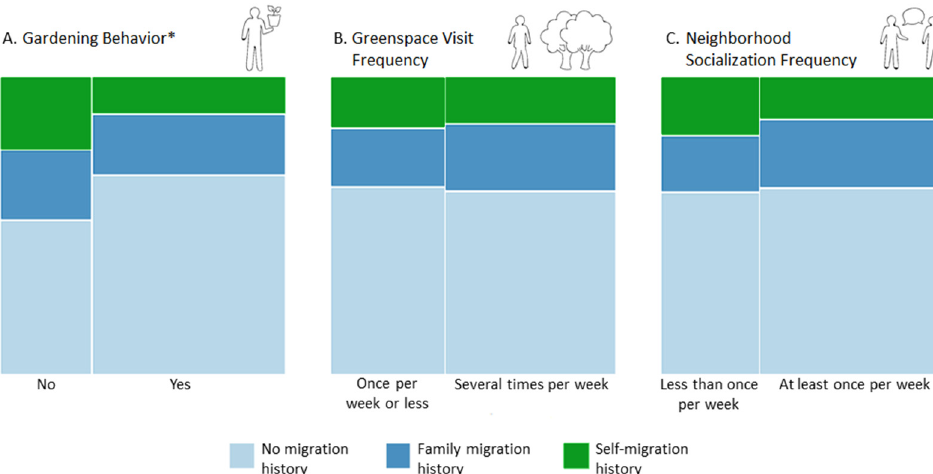
Figure 2. Mosaic plots depicting bivariate relationships between migration history and gardening behavior, greenspace visit frequency and neighborhood socialization frequency. The width of each bar represents the proportion of respondents ( n = 282) in the respective group. The height of the individual-colored sections within each bar represents the proportion of respondents in each group according to the levels within the variable migration history (i.e., no migration history, family migration history and self-migration history). The bivariate relationships depicted in the plots are between migration history and ( A ) gardening behavior, ( B ) greenspace visit frequency and ( C ) neighborhood socialization frequency. Significant bivariate associations according to Chi-squared analyses are denoted with (*) in the individual heading of each plot.